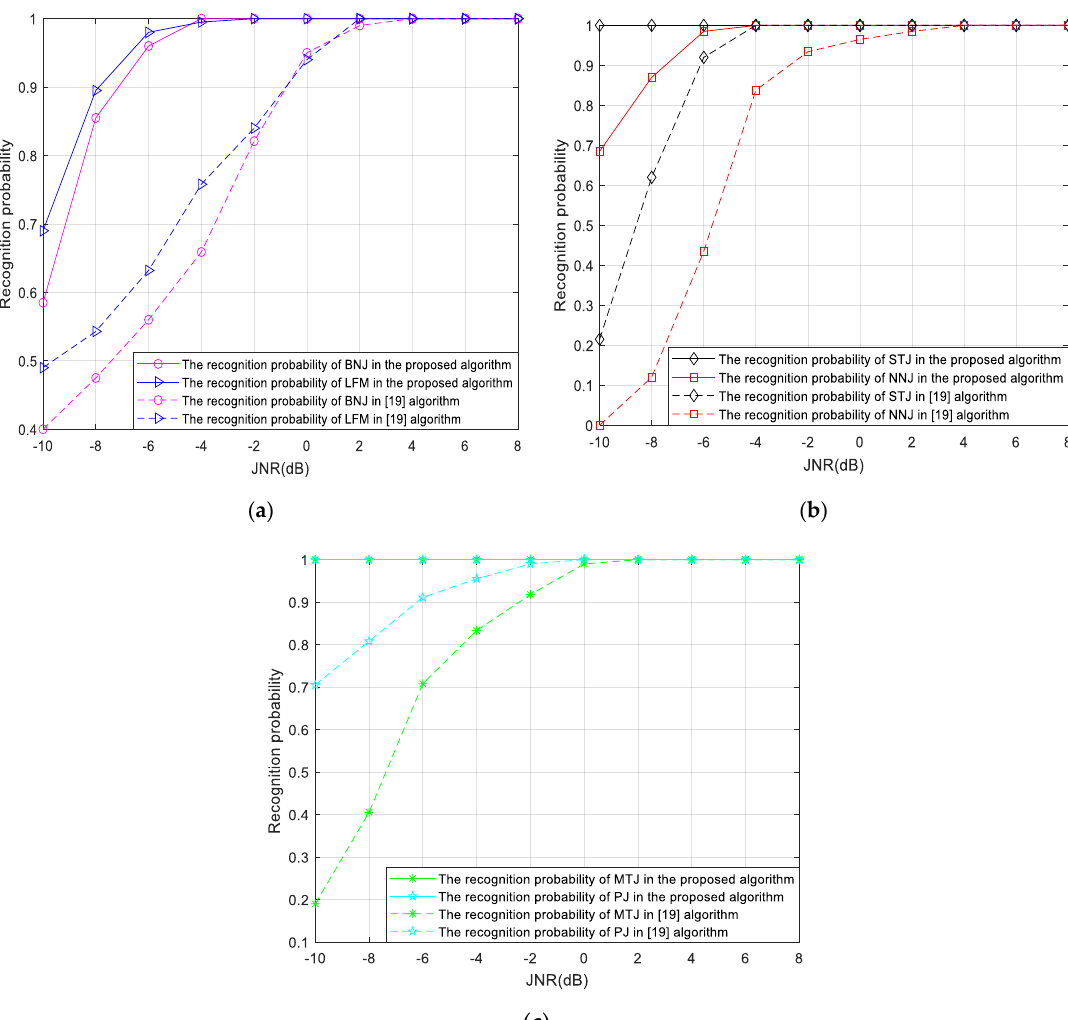
Figure 7. Recognition rate of the algorithm proposed in this study and the algorithm in [19]. ( a ) Recognition rate of broadband noise jamming (BNJ) and linear frequency modulation jamming (LFM); ( b ) Recognition rate of narrowband noise jamming (NNJ) and single-tone jamming (STJ); ( c ) Recognition rate of multi-tone jamming (MTJ) and pulse jamming (PJ).